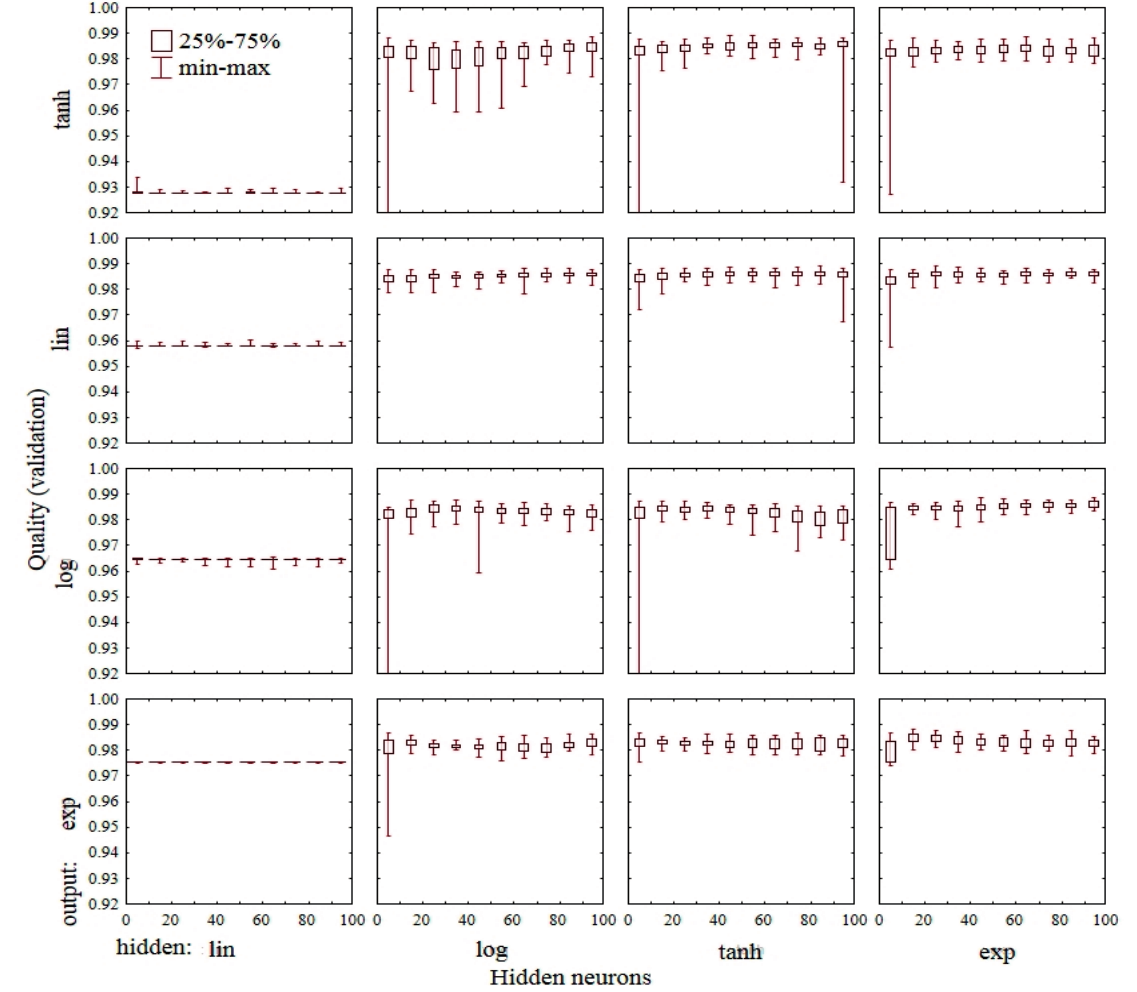
Figure 4. Quality value of network validation considering number of neurons in hidden layer n ∈ <1 ÷ 100> and different transfer function of hidden and output layer for COD